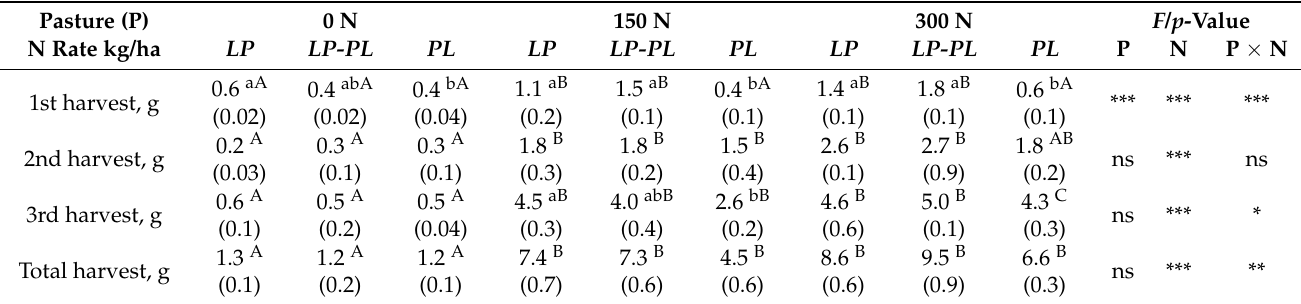
Figure A1. Plantago proportion in the perennial ryegrass—Plantago pasture mix ( LP-PL ) affected by fertilization and the growth/temporal cutting stage. Means with different letters are significantly different at p < 0.05, AB is the temporal cutting effect and ab the fertilization effect. Table A2. Dry matter yield, C:N ratios and N uptake/use efficiencies from Lolium perenne ( LP ) and Plantago lancelota ( PL ) swards as affected by different fertilization rates.